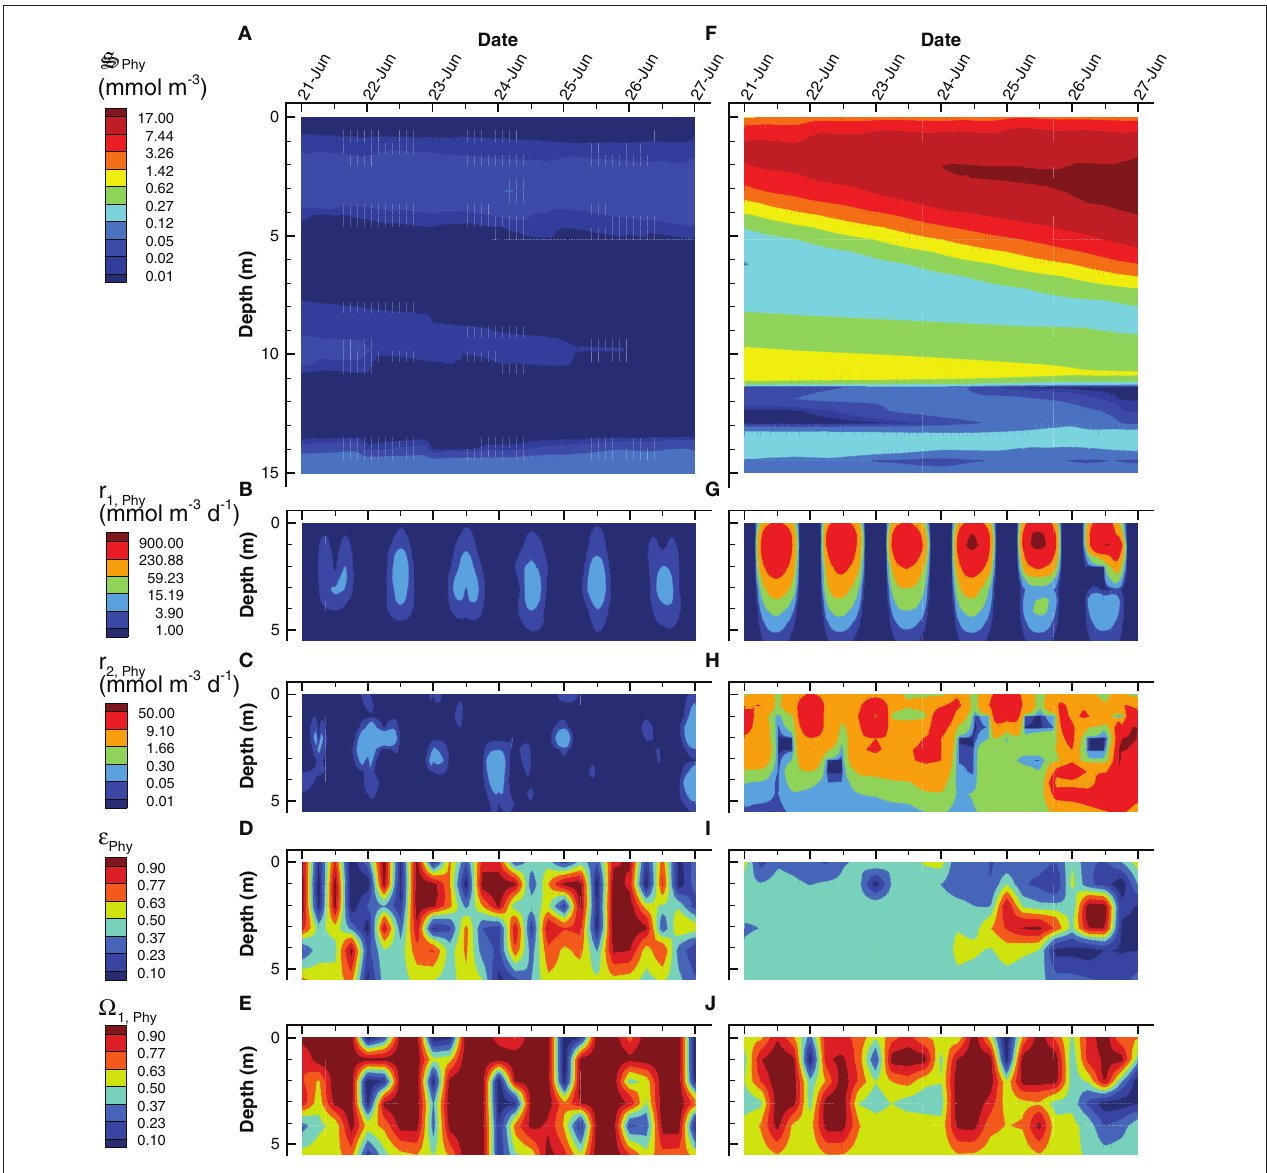
FIGURE 8 | Contour plots of phytoplankton concentration, [ S Phy ] (A,F) , rates for the two associated reactions, r 1, Phy (B,G) and, r 2, Phy (C,H ) and two optimal control variables, ε Phy (D,I) , and (cid:127) 1, Phy (E,J) for the SIO (A–E) and LIO (F–J) simulations. Note, reaction rates and control variables are only plotted for the top 5m of the water column where the processes are